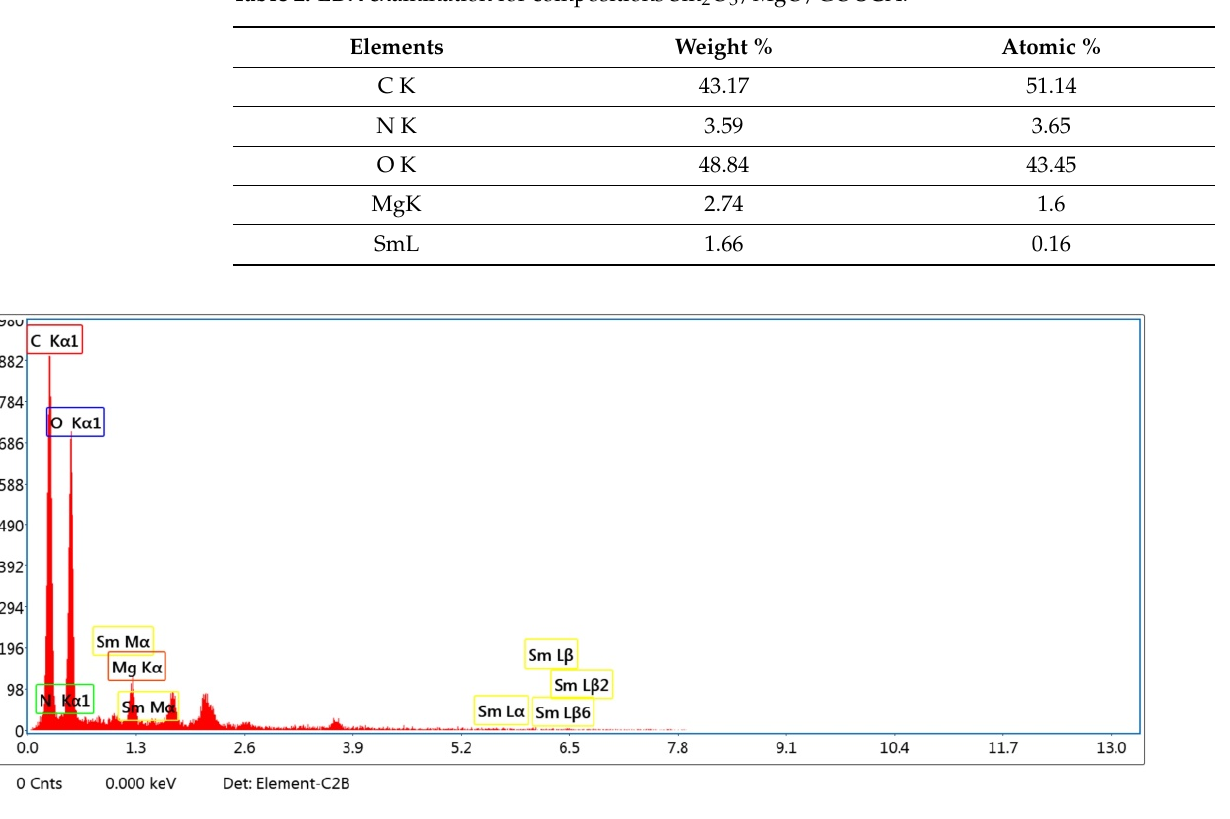
Figure 4. EDX analysis of the scaffold containing Sm 2 O 3 /MgO/GO@CA. Table 2. EDX examination for compositions Sm 2 O 3 /MgO/GO@CA.